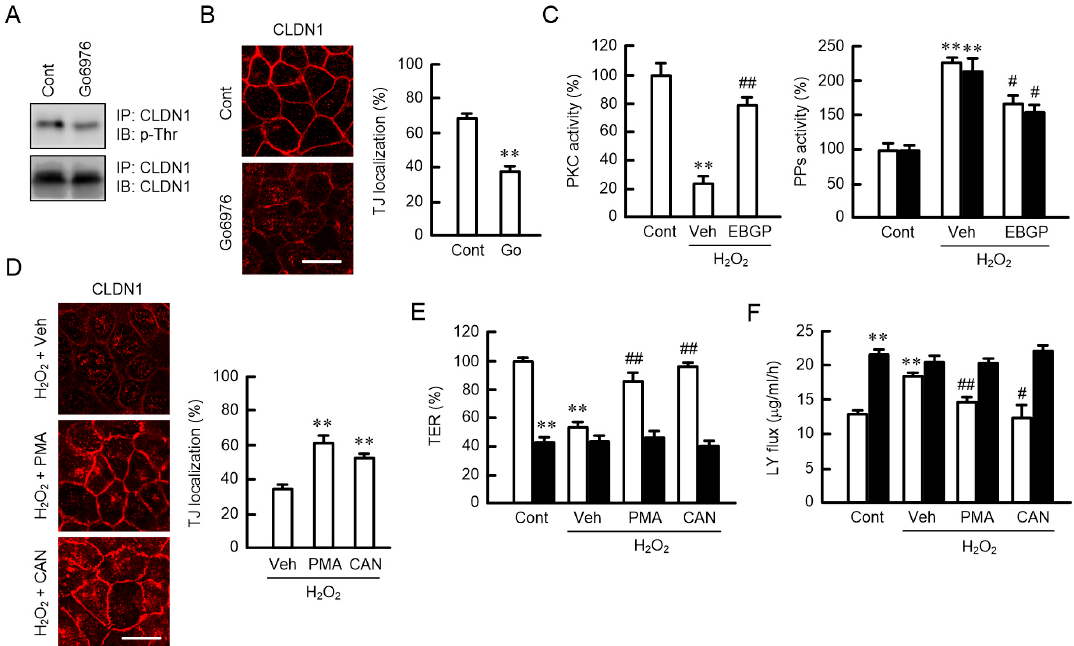
Figure 7. Upregulation of the TJ localization and phosphorylation of CLDN1 by PKC. ( A , B ) Cells were incubated in the absence (Cont) or presence of 10 µ M Go6976 (Go) for 30 min ( A ) or 6 h ( B ). ( A ) After immunoprecipitation with anti-CLDN1 antibodies, the immunoprecipitants were blotted with anti-p-Thr and anti-CLDN1 antibodies. ( B ) The cells were immunostained with anti-CLDN1 antibodies. Scale bars indicate 10 μ m. The TJ localization of CLDN1 is represented as the percentage of the total amount. ( C ) Cell lysates were prepared from the cells exposed to 200 μ M H 2 O 2 in the presence (EBGP) and absence (Veh) of 10 μ g/mL EBGP. Control cells (Cont) were not treated with H 2 O 2 and EBGP. PKC activity was measured using a CycLex PKC Super Family Kinase Assay Kit. Protein phosphatase (PP) activities were measured using pNPP in neutral (open bars) and alkaline (closed bars) conditions.